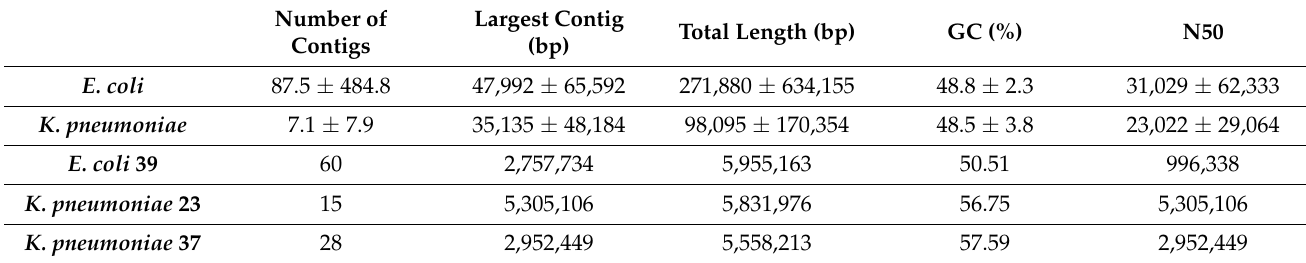
Table 2. An overview of general statistics (mean ± SD) obtained using the QUAST tool for the Scheme 39. and K. pneumoniae 23,